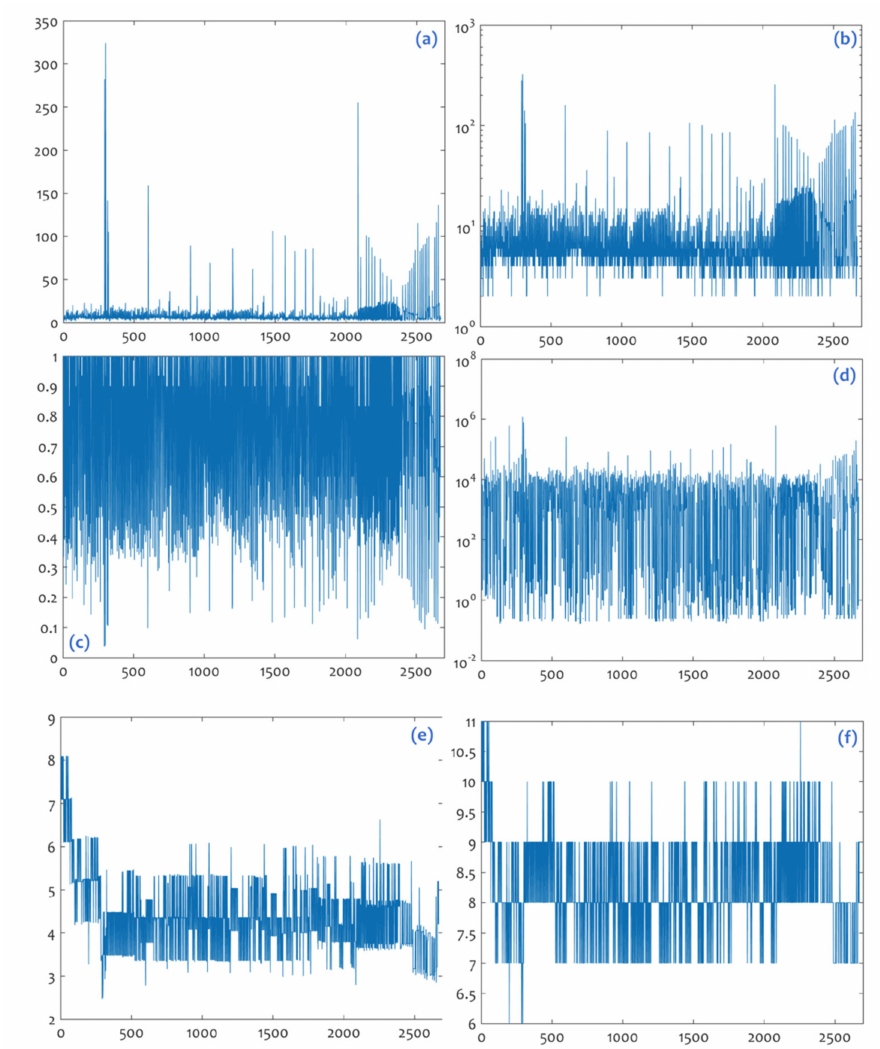
Figure 5. Secondary time-series of the network measures of ( a ) degree (at metric scale), ( b ) degree (at semi-log scale), ( c ) clustering coe ffi cient, ( d ) betweenness centrality (at semi-log scale), ( e ) closeness centrality, and ( f ) eccentricity (at semi-log scale), which are computed on the visibility graph associated to the available voltage oscillation time-series of TlInTe 2 (see Figure 1) and are ordered according to the source (TlInTe 2 ) time-series